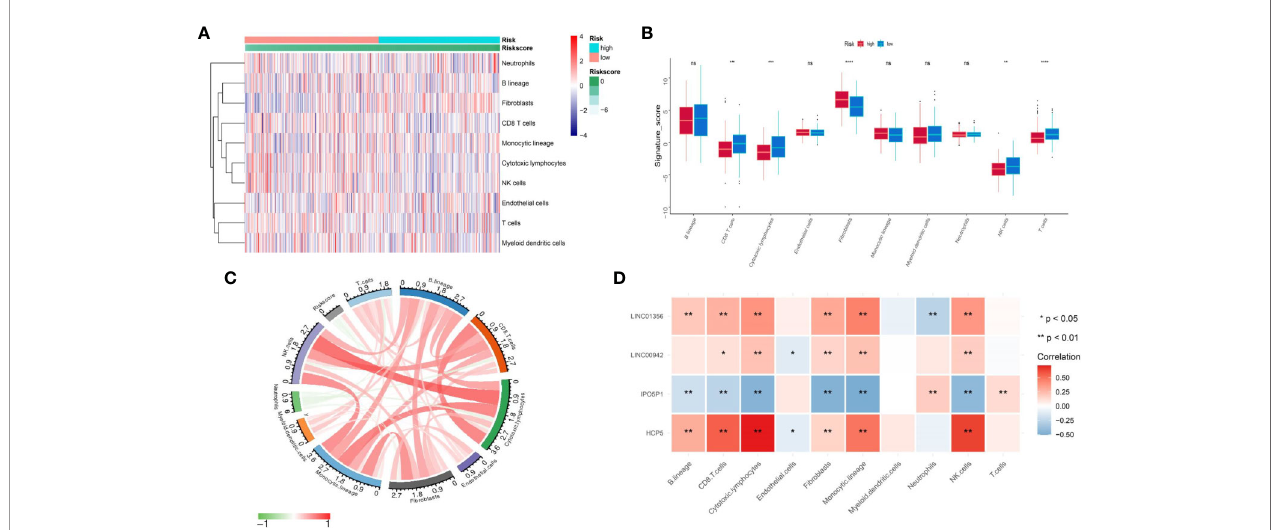
FIGURE 7 | Assess the difference in immune in fi ltration between the two groups. (A) Differences of 10 cell abundances calculated by MCP-counter method between two groups of patients. (B) Box plot of ten gene sets calculated by MCP-counter. (C) The correlation between risk score and ten TME in fi ltration cells. (D) Correlation matrix of IRL and ten TME in fi ltration cells. The blue indicated positive correlation and yellow indicated negative correlation. ns P ≥ 0.05, *P < 0.05, **P < 0.01, ***P < 0.001, ****P <